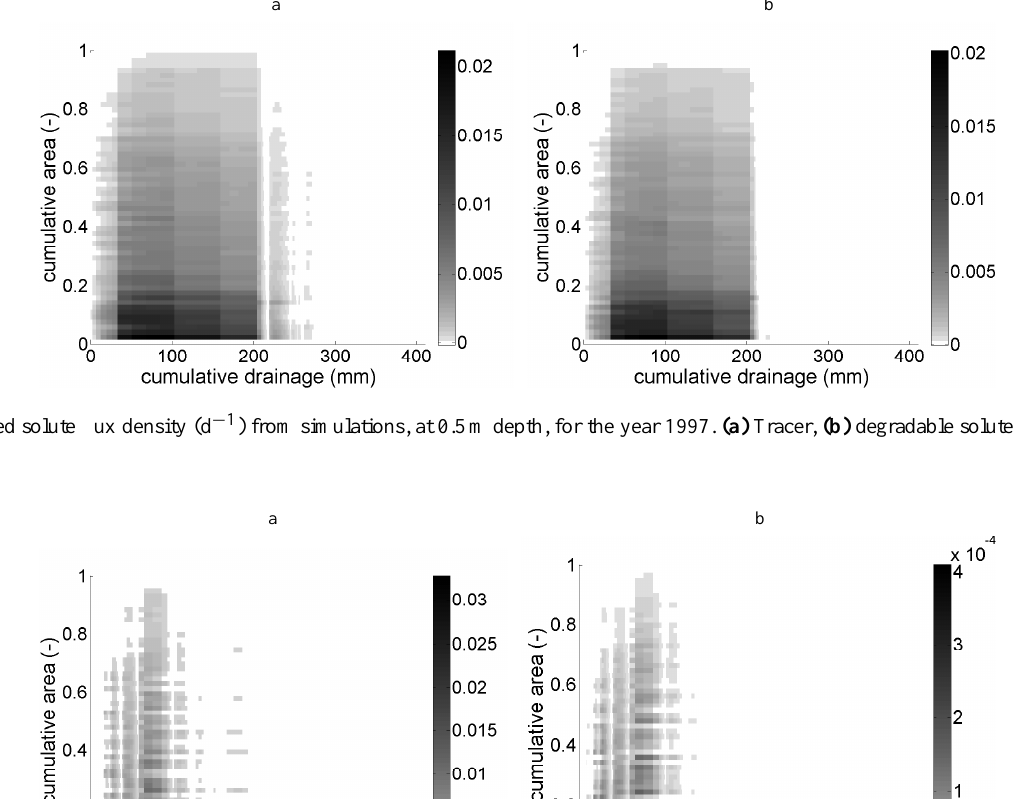
Fig. 11. Scaled solute flux density (d − 1 ) from simulations, at 0.5 m depth, for a steady state atmospheric flux of 2.5 mm d − 1 . (a) . Tracer (b) . Degradable solute (half-life time τ =10 d).